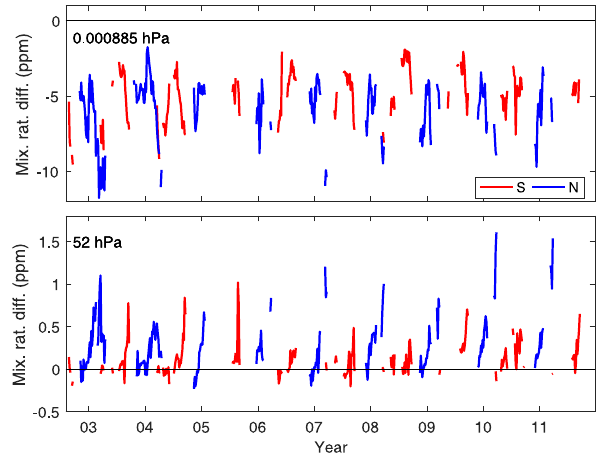
Figure 7. WACCM and GOMOS ozone mixing ratio difference from Fig. 6 in the Arctic 60–90 ◦ N and in the Antarctic 60–90 ◦ S. The colour coding symbols: S is Antarctic and N is